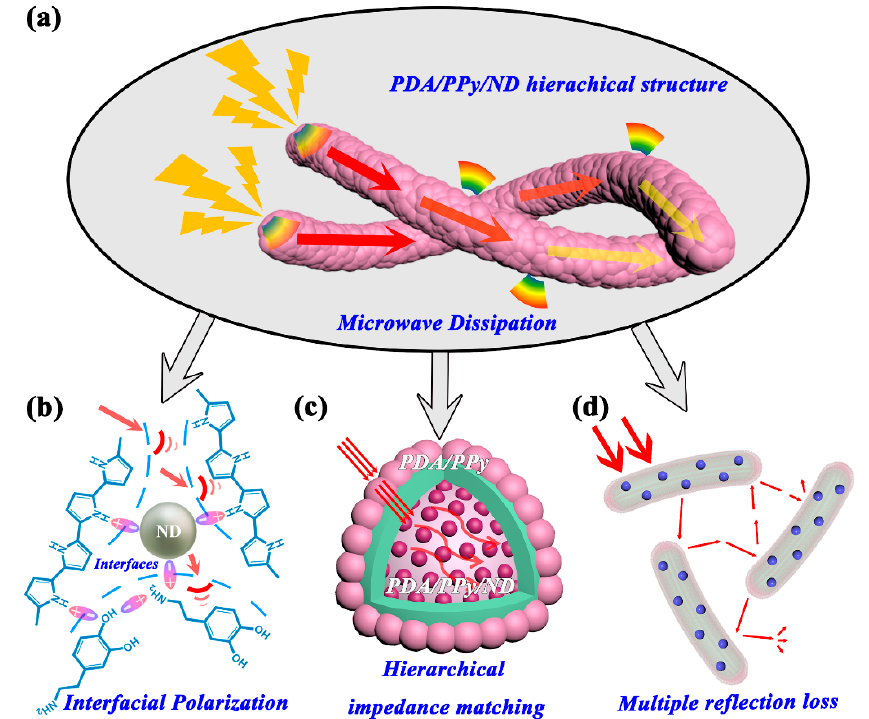
Figure 6. Schematic of the microwave-absorption mechanism for PDA/pPy/ND hierarchical struc- tures. ( a ) the microwave dissipations in PDA/PPy/ND hierarchical structures, ( b ) the interfacial polarization losses in the hybrids, ( c ) the Hierarchical impedance matching between PDA/PPy and PDA/PPy/ND, ( d ) the multiple reflection loss in the hybrids.